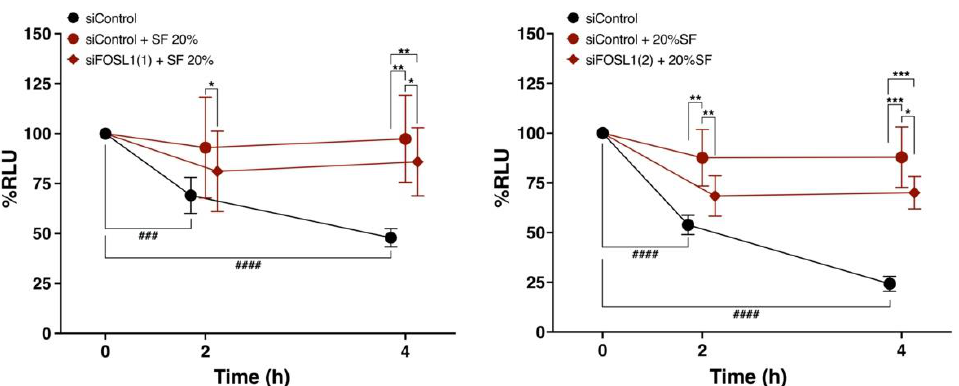
Figure 7. Comparison of percent cell viability between FOSL1-knockdown ADSCs using two different FOSL1 siRNAs and the siControl group following SF treatment. Comparison of changes in percent cell viability over time between FOSL1-knockdown ADSCs and the siControl group following treatment with 20% SF from six Knee OA patients ( n = 6). SF was diluted in saline. * p < 0.05, ** p < 0.01, *** p < 0.001, ### p < 0.001, #### p < 0.0001. Data are expressed as mean ± S.D.